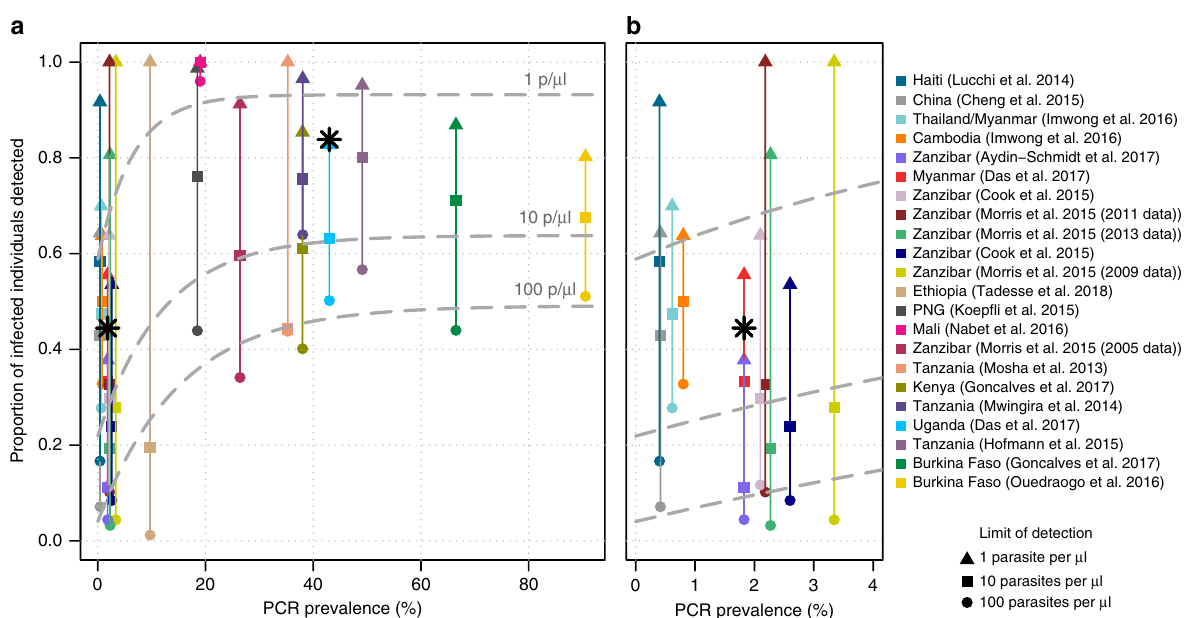
Fig. 3 The proportion of PCR-positive infections with parasite densities above three thresholds. a all datasets — the triangle, square and circle represent the proportion of individuals in each dataset with parasites densities greater than 1, 10 and 100 parasites per µ l, respectively (assuming 100% detection below the threshold and 0% detection above, for simplicity). b Zoom-in of the 0 – 4% prevalence area. The black stars indicate the actual proportion of infections detected using the ultra-sensitive RDT in Myanmar (left) and Uganda (right) 12 . The dashed grey lines show the best- fi t line (of the form: proportion detected = a – b * exp( m * PCR prevalence) for the estimated proportion of PCR-positive individuals that would be detected using the three limits of detection. The details of the fi tting and the parameter values for the three lines are shown in Supplementary Note 2. Source data are provided as a Source Data fi